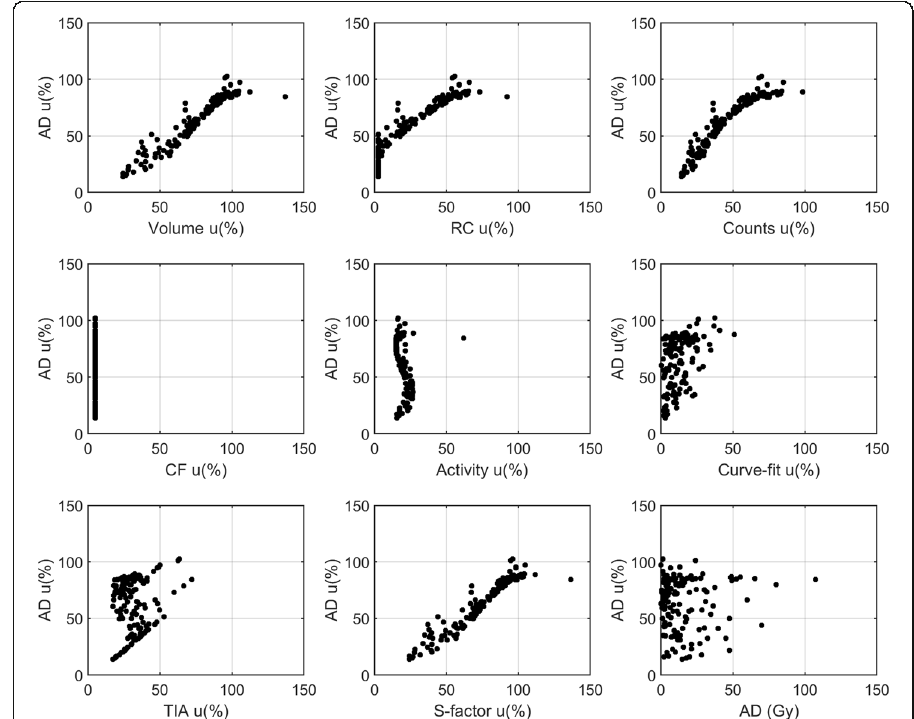
Fig. 3 Relationship between absorbed dose uncertainty ( y -axis) and volume, RC, counts, CF, activity, curve fitting parameters, time-integrated activity and S-factors uncertainties ( x -axis). The graph at the bottom right shows the absorbed dose (Gy) against the absorbed dose